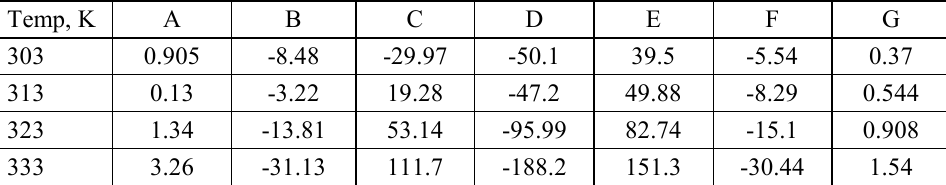
Table 4. Effect of the diethyl nicotinamide.